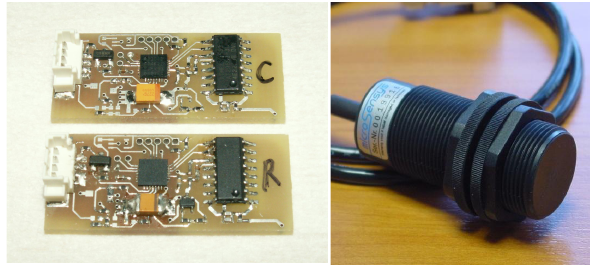
Figure 12. Block diagram of the transponder with integrated units for signal analysis and connections for the sensor